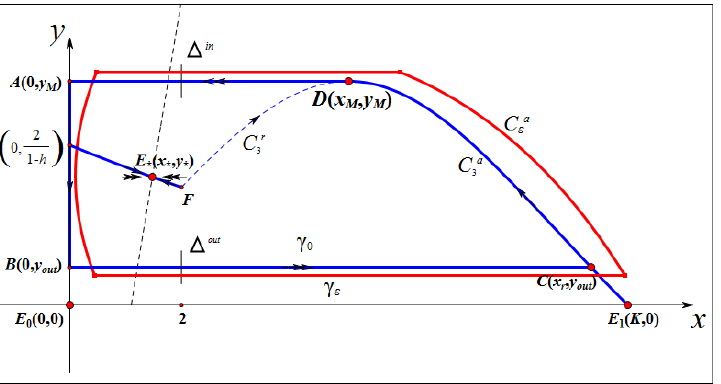
Figure 2. The critical manifold C 0 contains attracting part C a line is the predator isocline; the red dot is the fold point D ( x M , y M ) ; the solid blue line is the slow–fast cycle γ 0 ; the double and single arrows are fast and slow flows, respectively; and the solid red is the stable relaxation oscillation γ ε